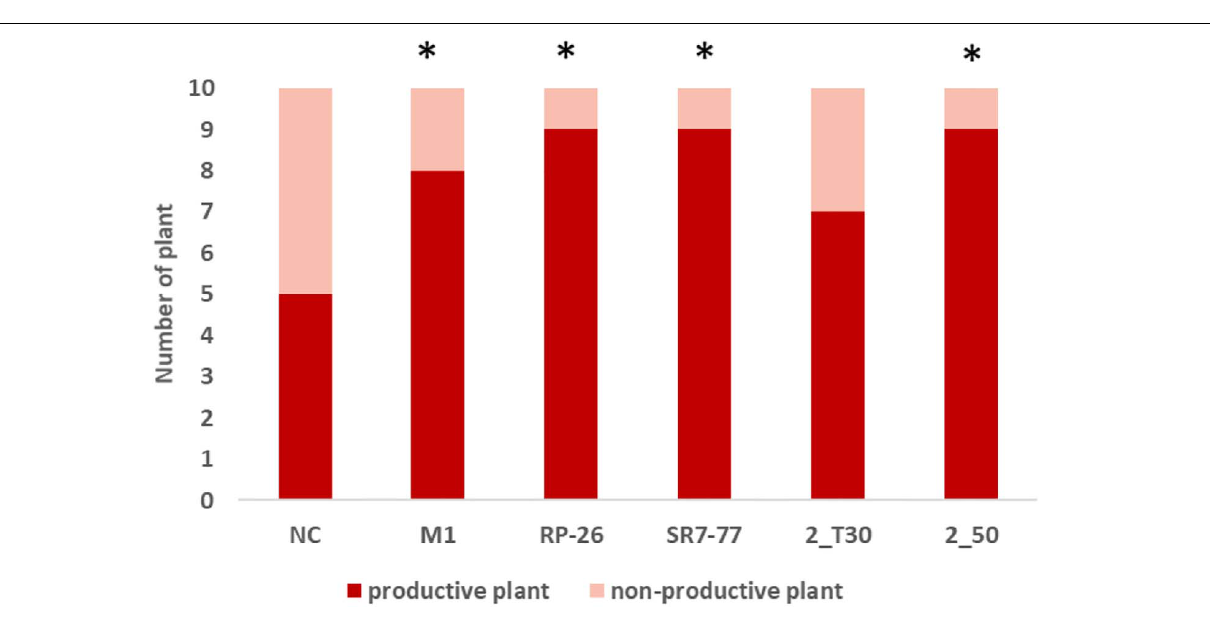
FIGURE 3 | Number of productive and non-productive tomato plants under the water stress condition. Red bars indicate the number of plants that produced at least one tomato; pink bars indicate the number of plants that did not produce any tomatoes. Stars indicate statistical differences in comparison with NC ( p -value < 0.05; exact binomial test). NC, non-bacterized control plants; Micrococcus yunnanensis M1, Bacillus simplex RP-26, Pseudomonas stutzeri SR7-77, Paenarthrobacter aurescens 2_T30, and Paenarthrobacter nitroguajacolicus 2_50